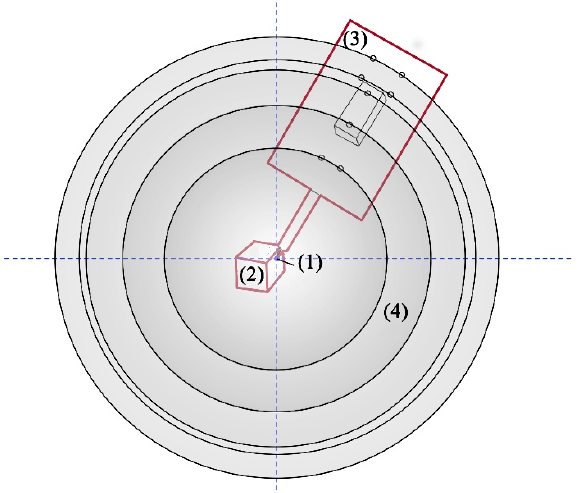
Figure 2. Schematic diagram of the self-calibration method: (1) Stylus tip center (2) The object to be measured (3) The light pen (4) The spherical surface fitted.